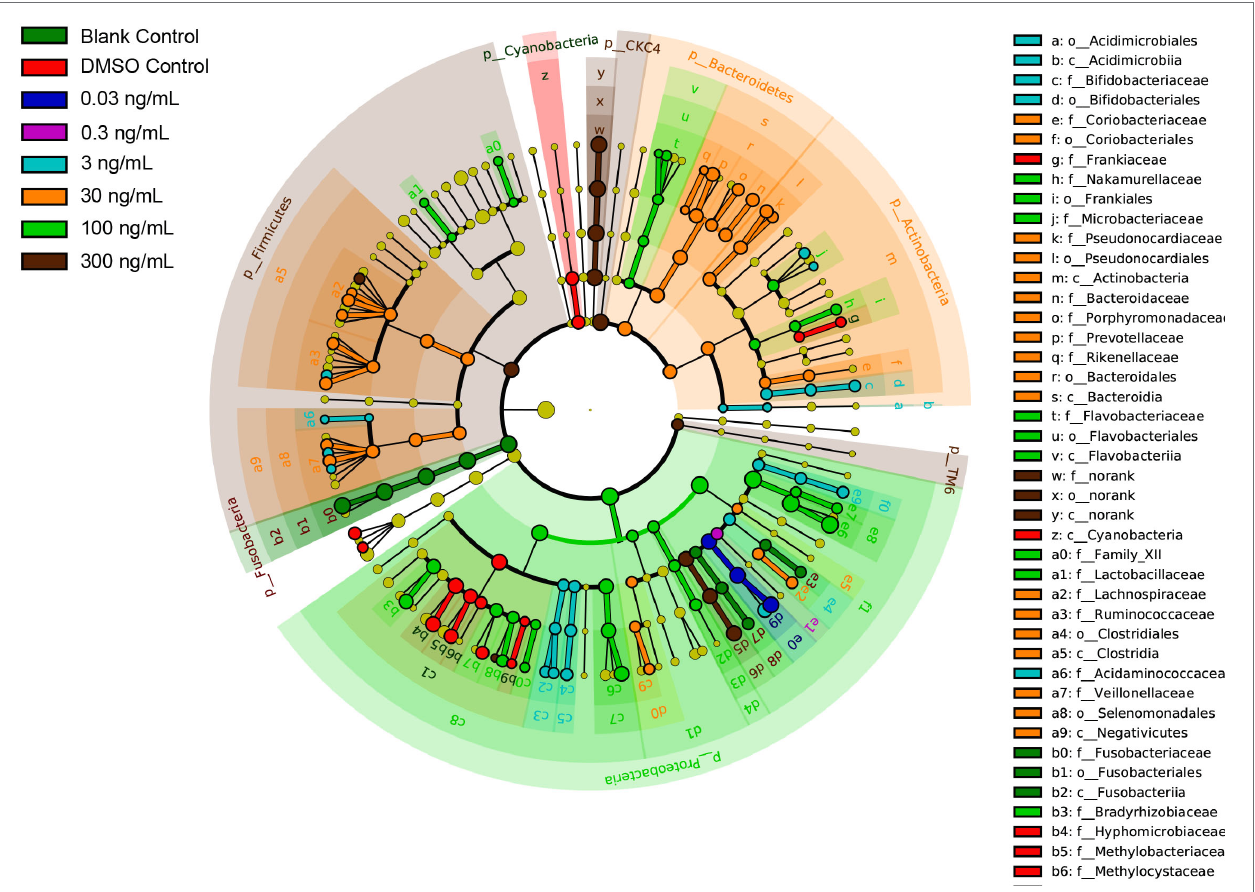
FIGURE 5 | LDA Effect Size (LEfSe) cladograms of pairwise analysis for long-term TCS exposure with 16S rDNA sequence analysis in microbiota within the gastrointestinal tract of zebrafish. The cladogram shows the taxonomic levels represented by rings with phyla at the innermost ring and genera at the outermost ring, and each circle is a member within that level. Different taxa at class, order, and family levels are listed on the right side of the